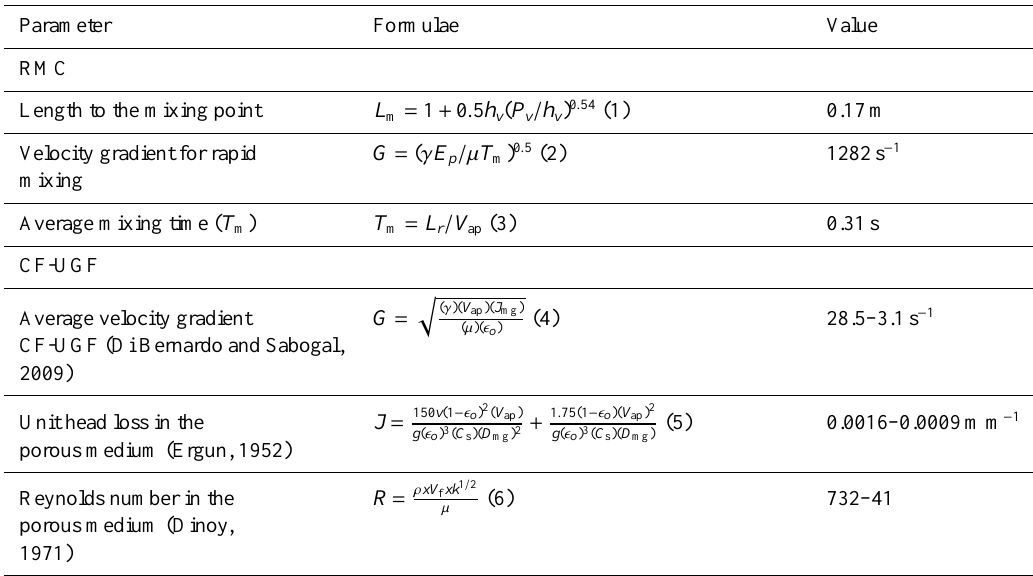
Figure 1. Layout of the treatment system (1–5: monitoring points of water quality).